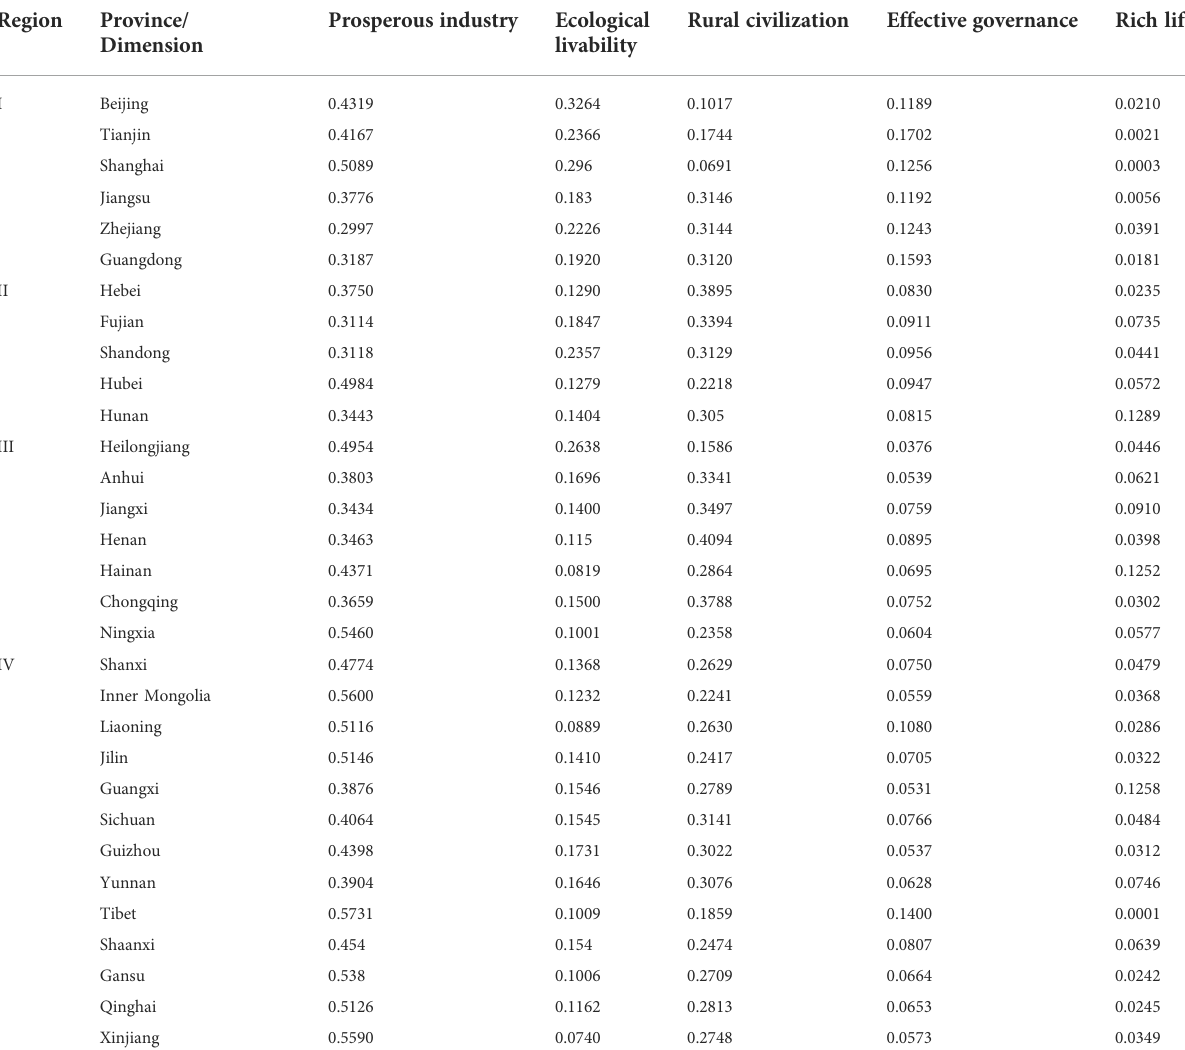
TABLE 9 Forecast results of each dimension proportion of 31PLAD in 2025.